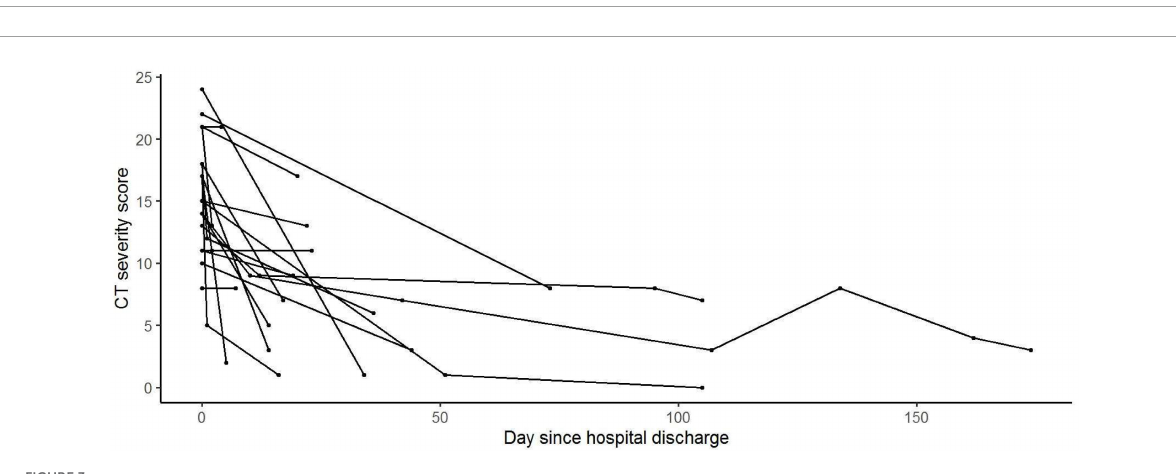
FIGURE3 CT-SS evolution after hospital discharge. Generalized linear mixed models (GLMMS) were used to analyze the evolution of the CT’s Thirona scores with time during and after the hospital